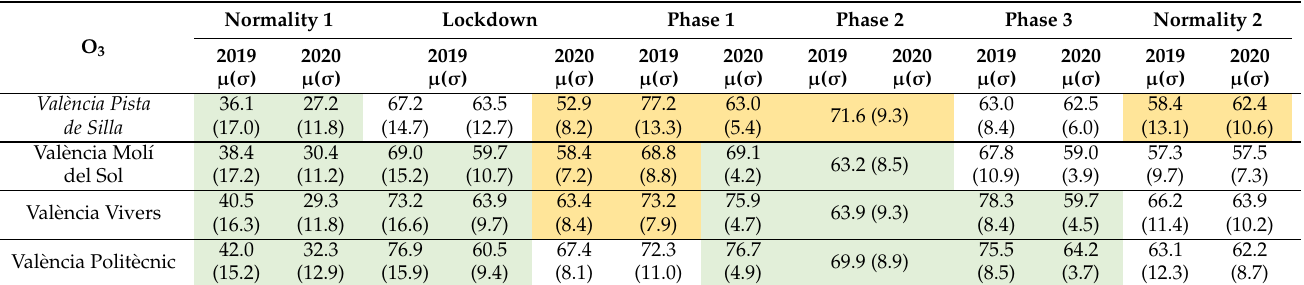
Table 4. O 3 mean and standard deviation are expressed in µ g · m − 3 . A green color denotes significant ( p -value < 0.05) decreases, whereas an orange color denotes significant increases between 2019 and 2020. O